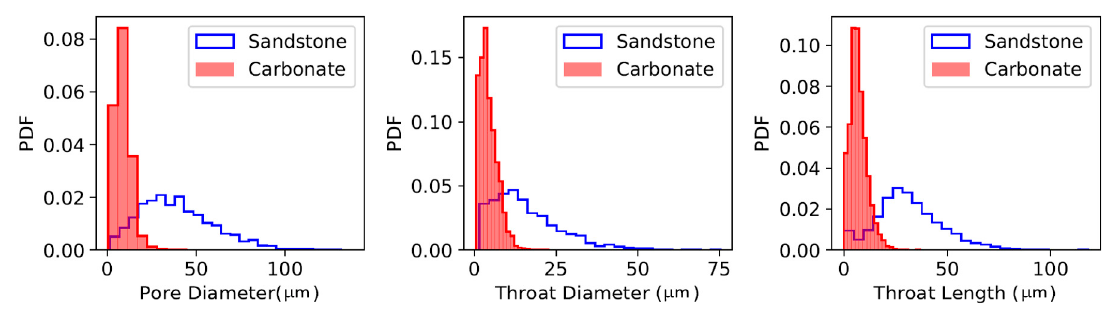
Figure 3. Statistics of the sandstone and carbonate pore network extracted.